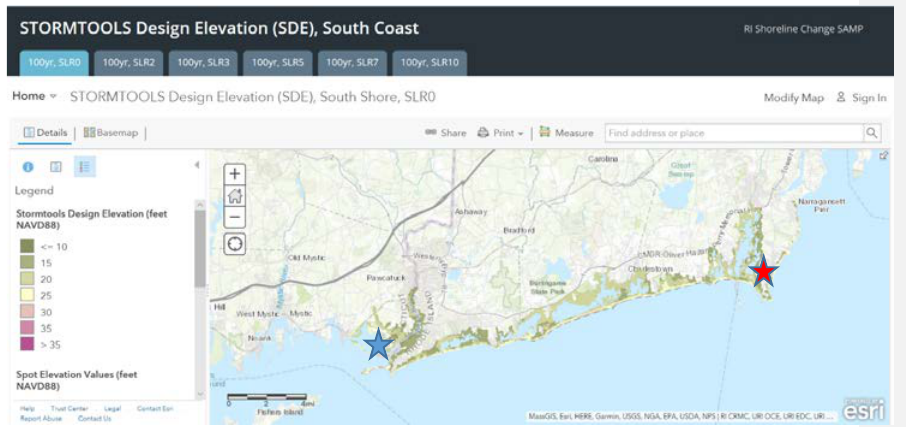
Figure 5. User interface for the STORMTOOLS Design Elevation (SDE) Maps, southern RI coast line (South Coast), no SLR. The case selected was the 100-yr event with no SLR. Blue star, Napatree Point, Westerly, and red star, Point Judith, South Kingstown. The units on the tab are in ft of SLR. (https: // crc- uri.maps.arcgis.com / apps / MapSeries / index.html?appid = 3ba5c4d9c0744392bec2f4afb6ee228.